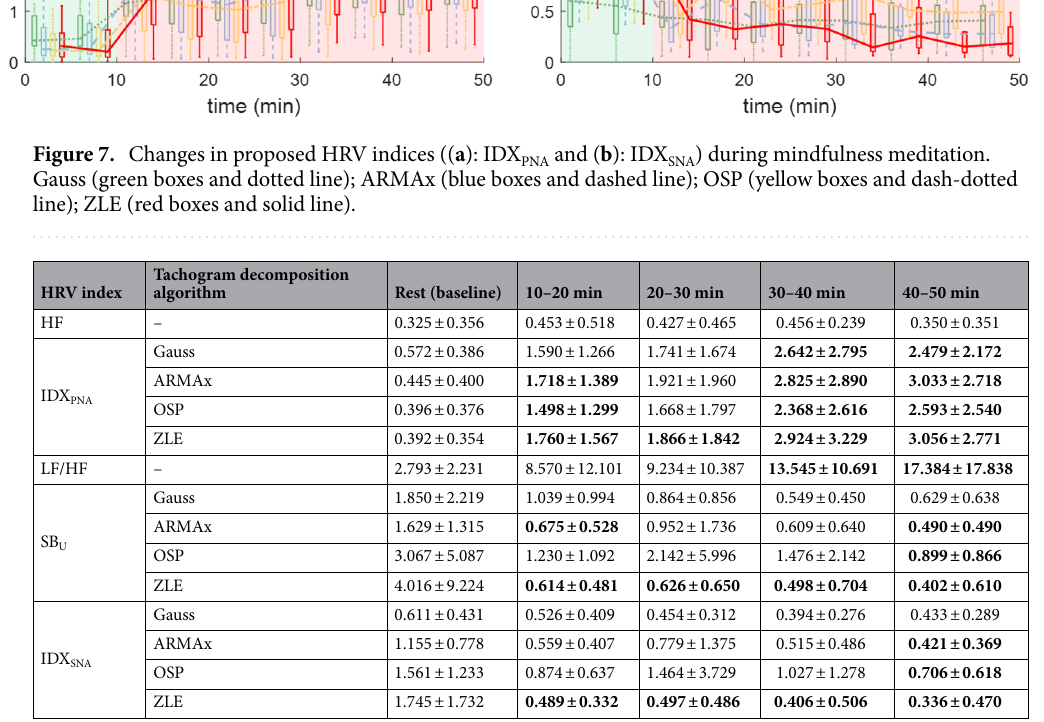
Table 2. Mean ± standard deviation of HRV indices (HF, IDX PNA , LF/HF, SB U , and IDX SNA ). Bold text represents a statistically significant difference between rest and each meditation phase (p < 0.000005). HF and IDX PNA are the HRV indices for vagal tone, and other indices (LF/HF, SB U and IDX SNA ) indicate sympathetic tone. In all meditation phases, all IDX PNA s of ZLE were significantly increased, and statistically significant decreases were observed in all SB U s and IDX SNA s of